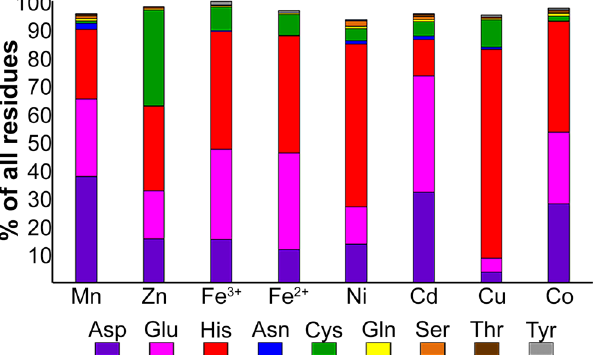
Figure 3. Selected amino acid propensities of the different metals. For each metal, the percentage of each residue is defined as the number of times that a specific residue was bound to the metal divided by the number of all residues bound to the metal. The different residues are presented in different colors: Aspartate in purple, glutamate in pink, histidine in red, asparagine in blue, cysteine in green, glutamine in yellow, serine in orange, threonine in brown and tyrosine in gray.